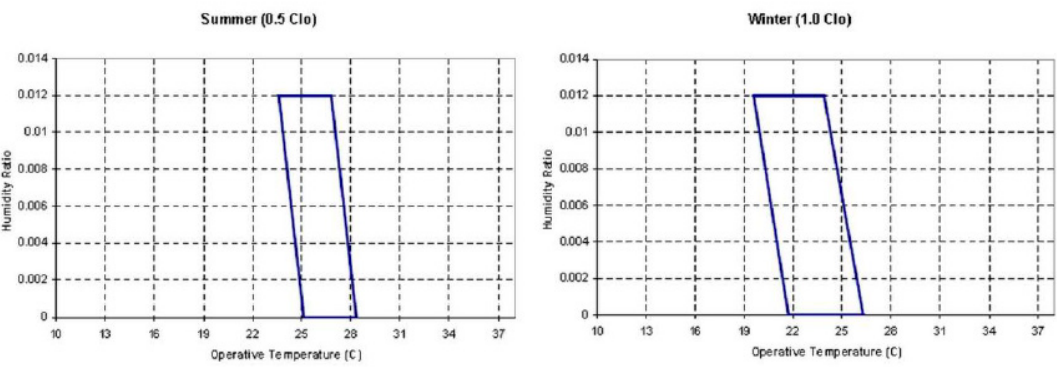
Figure 6. Comfort area (area between blue lines) for summer clothes region ( left ) and winter clothes region ( right ) [32].